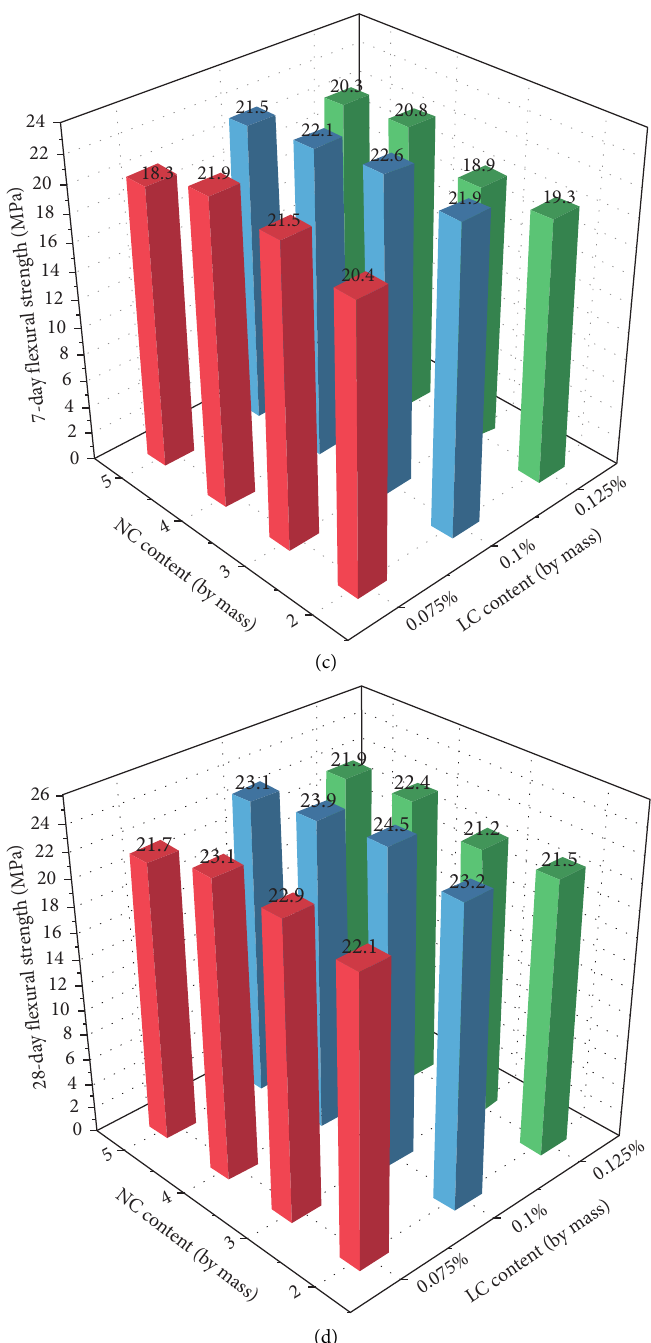
Figure 4: UHPC flexural strength with LC-NC combined